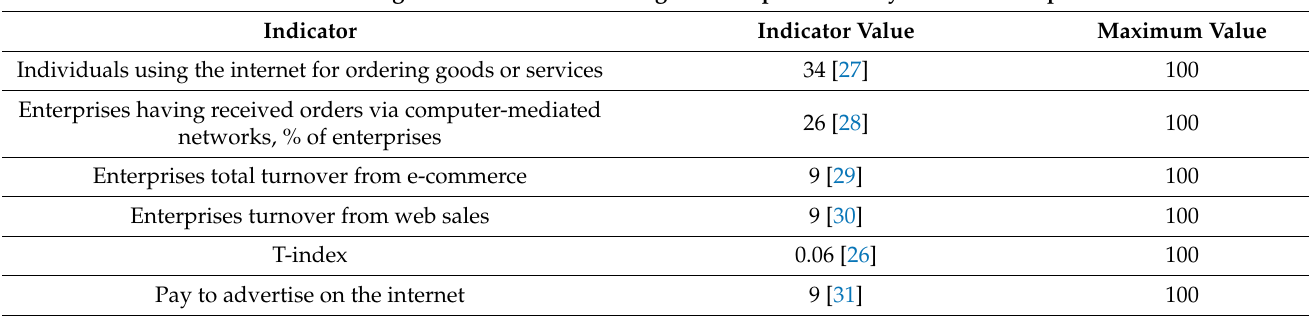
Table 3. The components of market conditions in the digital dimension (the table refers to the Republic of Serbia and was made in the likeness of the EIDES